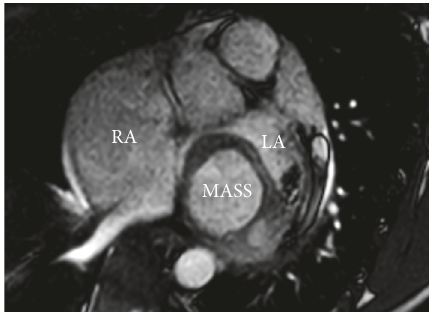
Figure 4: CMR transverse plane image of the LA mass showing its circular shape in cross-section. LA: left atrium; RA: right atrium.